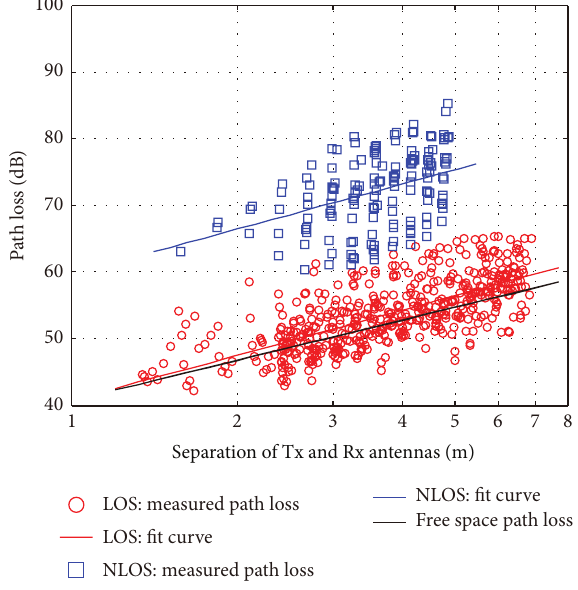
Figure 2: Scatter plots of the path loss, the corresponding fit curves, and free space path loss.